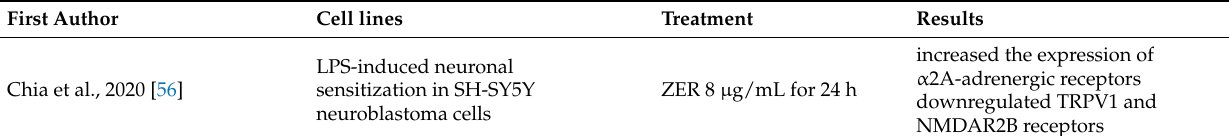
Table 1. In vitro studies on the effect of ginger extract and its